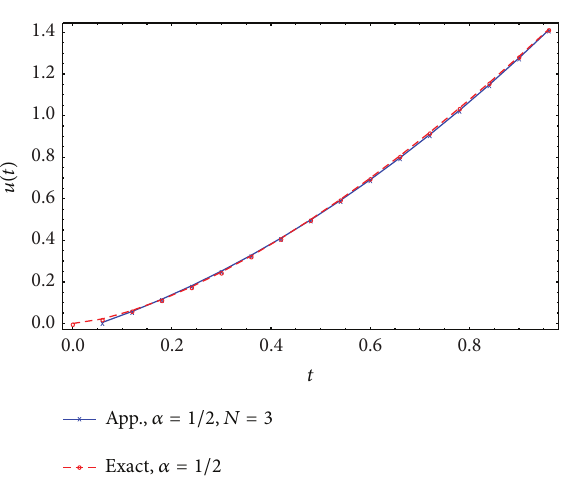
Figure 2: Exact and approximate control.